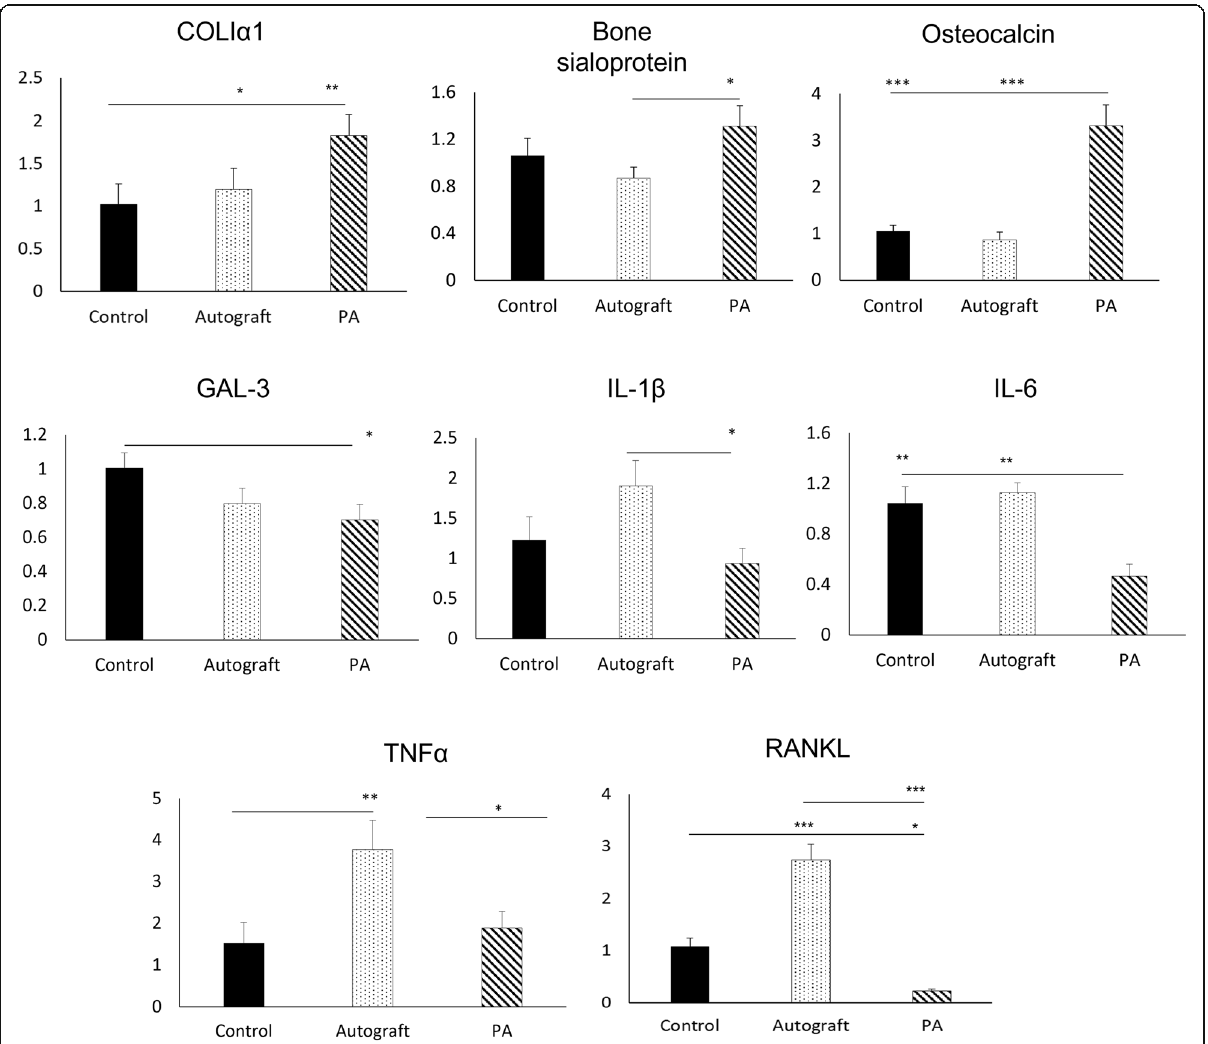
Fig. 6 Relative mRNA expression of selected inflammatory and early bone-forming markers from different groups implanted in aged rat calvaria bone defects after 2 weeks. Unfunctionalized scaffold (Control), functionalized scaffold (PA), and autograft. Data are presented as fold change normalized to GAPDH (* p < 0.05, ** p < 0.01, *** p <